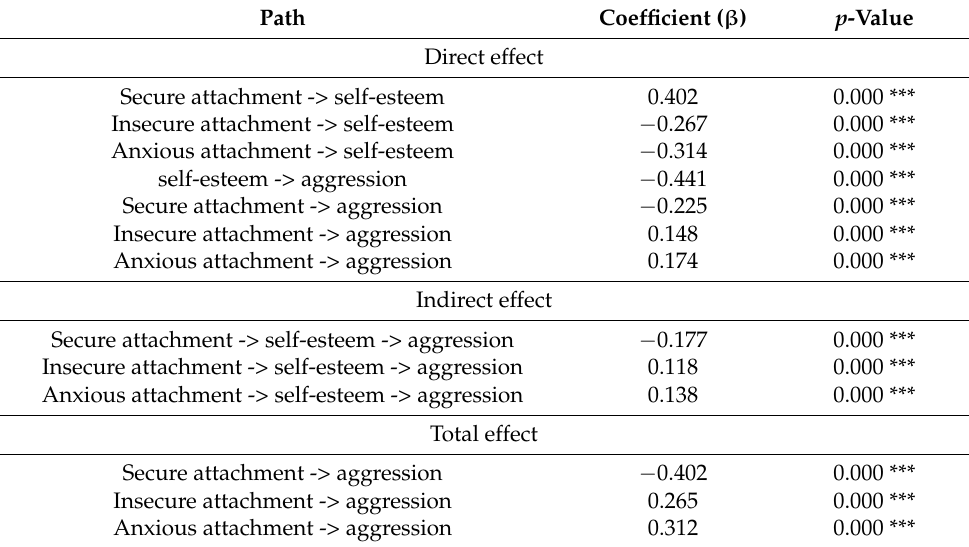
Table 4. The results of hypothesis